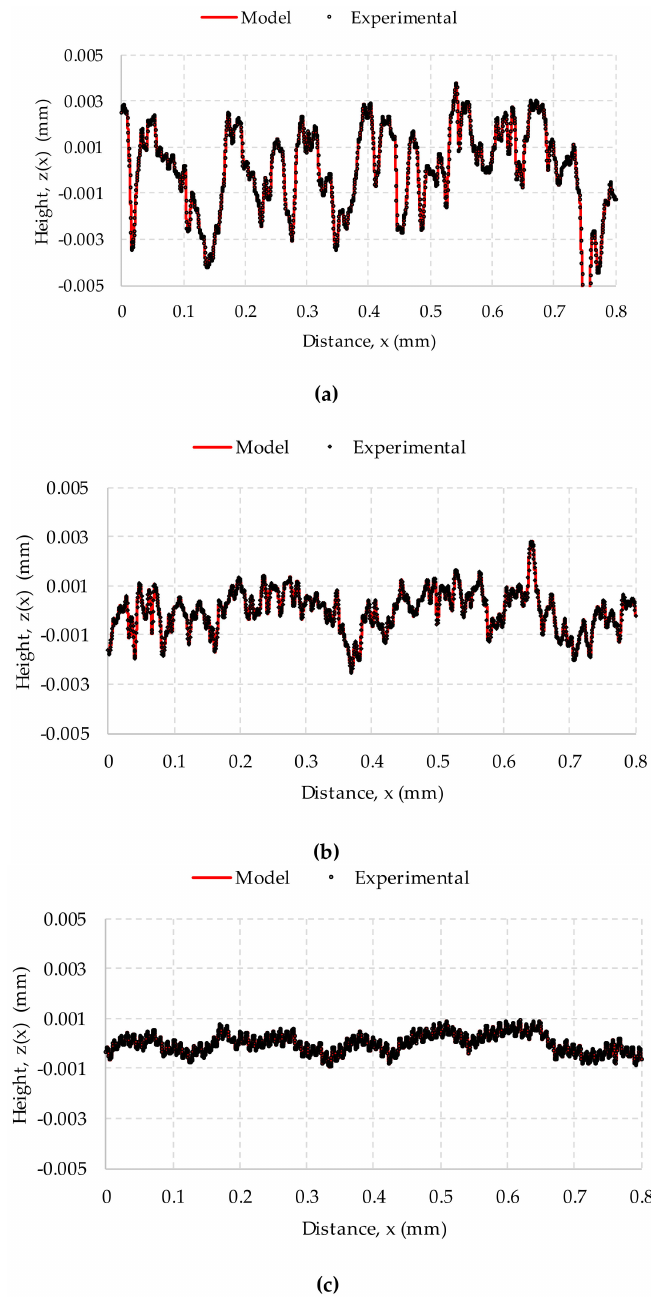
Figure 2. Direct comparison between measured and simulated 2D profiles: ( a ) rough specimen (No. 1); ( b ) medium rough specimen (No. 2); ( c ) Smooth specimen (No. 3). Surface profiles of the three specimens were measured at the interval of 0.01 mm ( y -axis